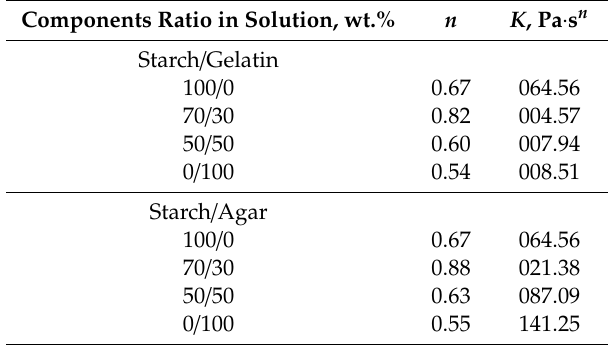
Table 1. Fitting parameters of the power law model Equation (2). Components Ratio in Solution,